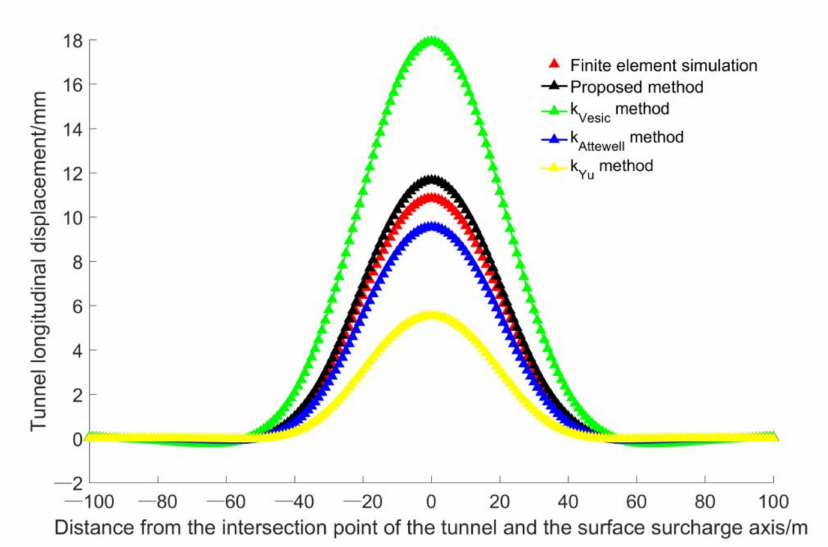
Figure 9. Comparison of the analytical solution and finite element